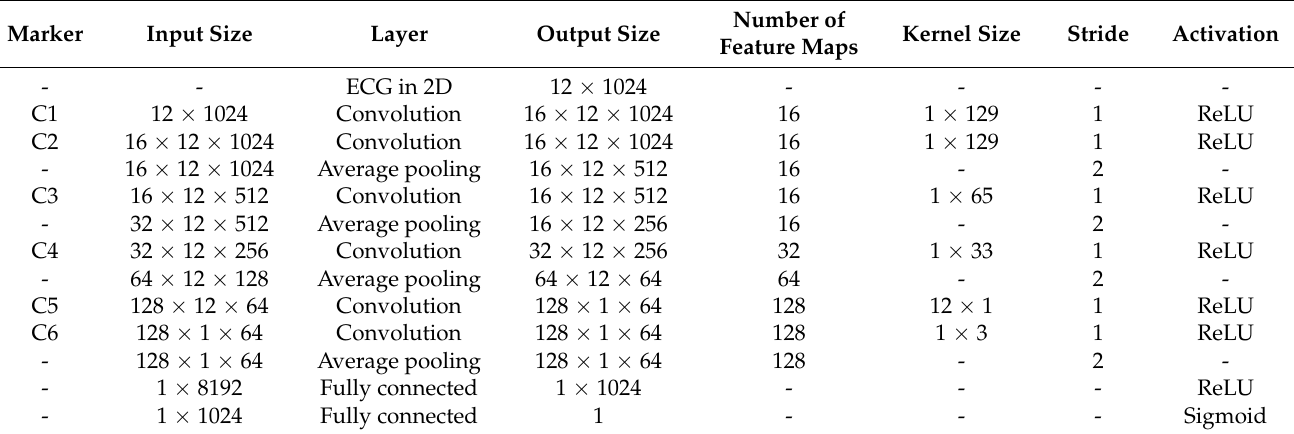
Figure 3. Data preprocessing and model structure demonstrated with feature maps The upper part of the figure demonstrates a simplified workflow to extract VPC (ventricular premature contraction) waves from the raw data. The 12 cropped VPC waves will be further stacked together to form a 12 × 1024 matrix for model input. The lower part of the figure demonstrates a simplified structure of the model with feature maps passed through the model. The red square is the kernel of each CNN layer. The number of feature maps and the ratio of feature maps are modified for better demonstrations. C1 − C6 is the label for each CNN layer, which matches the maker used in Table 2. Table 2. Detailed parameter of the model used in this study.